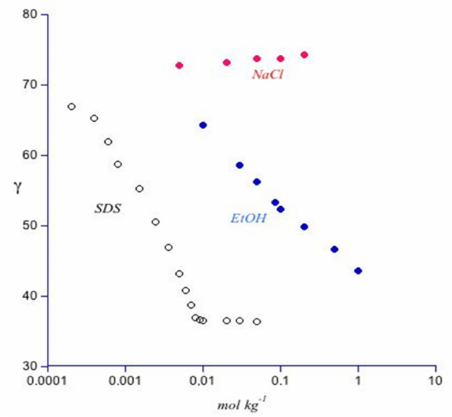
Figure 2. Variation of the surface tension of aqueous mixtures as a function of composition, in arbitrary scale: data refer to NaCl, full line; ethanol, empty circles; and a generic surfactant. When NaCl allows for increasing the surface tension, the other two species decrease it. Surfactants saturate the surface phase of water above a critical threshold, termed cmc .